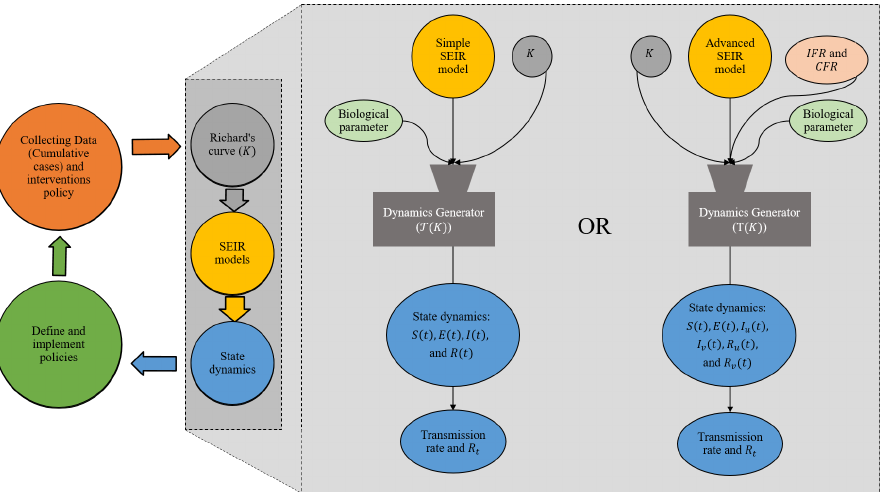
Figure 2. Diagram of the approach for estimating all state dynamics of the SEIR models using the dynamics